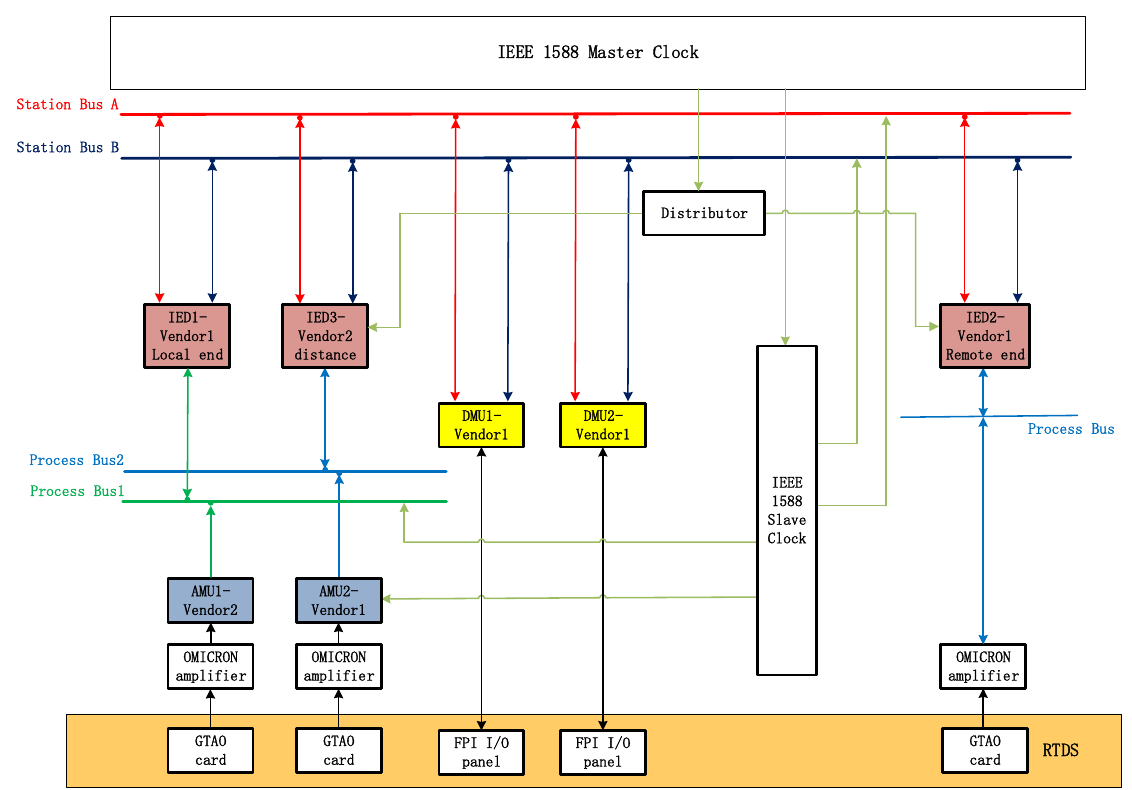
Figure 8. Future intelligent transmission network substation laboratory implementation of PRP- only architecture.